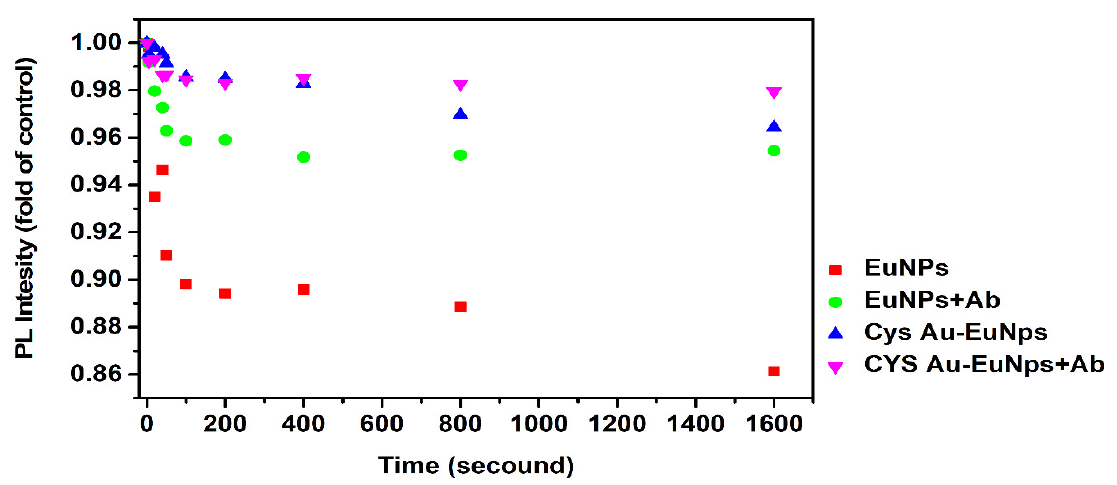
Figure 12. PL intensity visualization of changes in Eu NPs, Eu NP + Ab conjugate, Cys Au-EuNPs, and Cys Au-EuNPs + Ab conjugates in response to UV irradiation normalized to the control (value of UV exposure over 0 s).